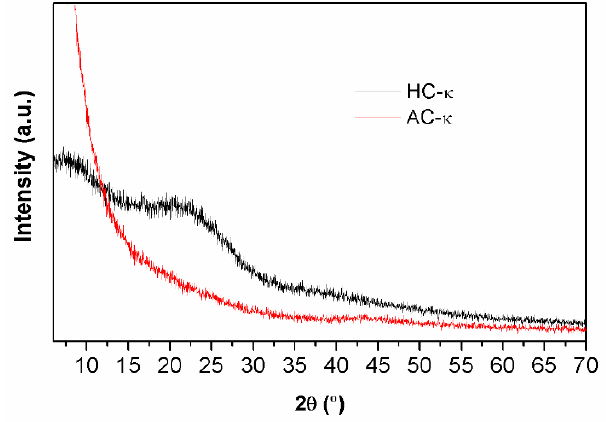
Figure 3. Powder XRD pattern of κ -carrageenan-derived hydrochar (HC) and activated (AC) carbons.